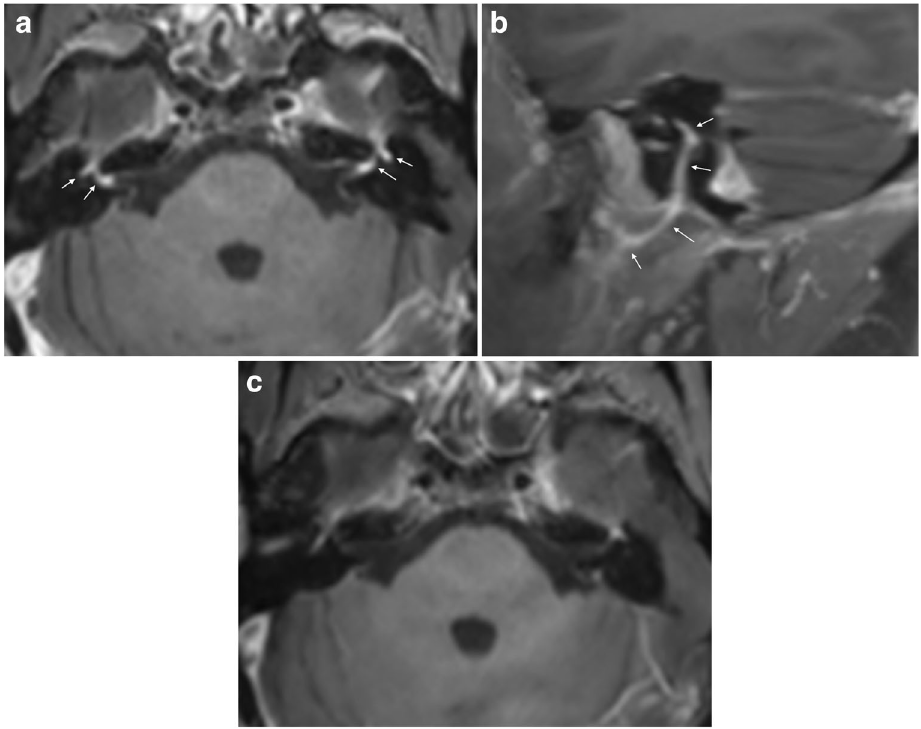
Fig. 2 Facial neuritis in LNB with typical disease course in a 55-year-old female. She suffered from back pain radiating to chest, arms, head and neck, especially intense at night time, and after 2 weeks she also developed bilateral facial palsy. CSF analysis showed 594 cells/mm 3 (normal range 0-5/mm 3 ) and production of Bb specific IgG and IgM antibodies. Axial post-contrast fat suppressed T1-weighted image ( a ) showed intense enhancement in the distal intracanalicular, labyrinthine and geniculate ganglion segments of both facial nerves (arrows point to